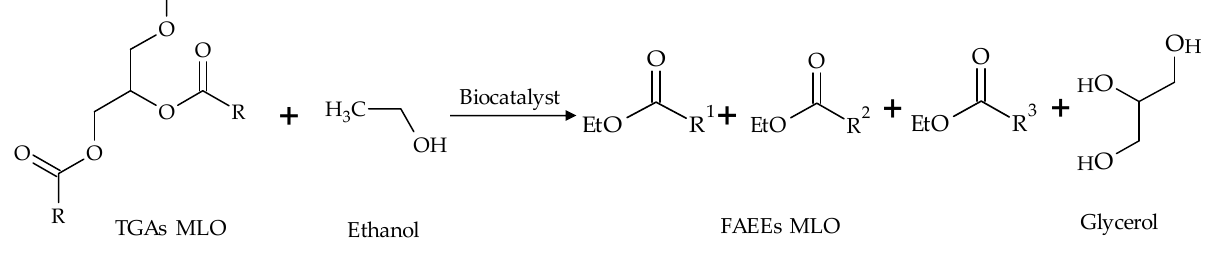
O H O H + + O H Glycerol